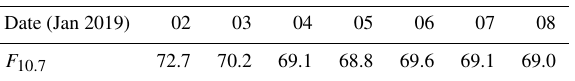
Table 1. Daily F 10 . 7 index for the 2–8 January 2019UT